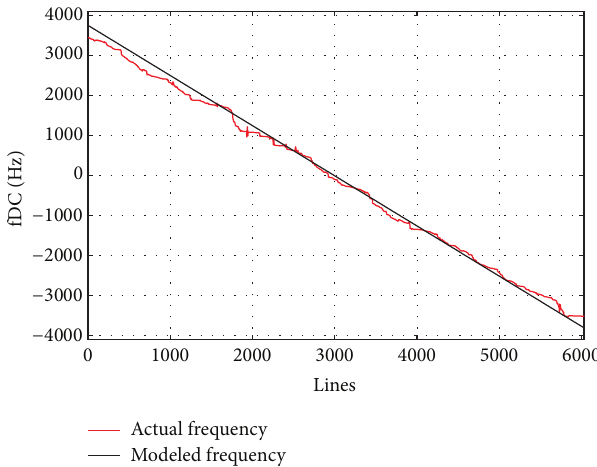
Figure 8: Modeled and actual Doppler frequency at pixel 4000 (range) from the first to the last